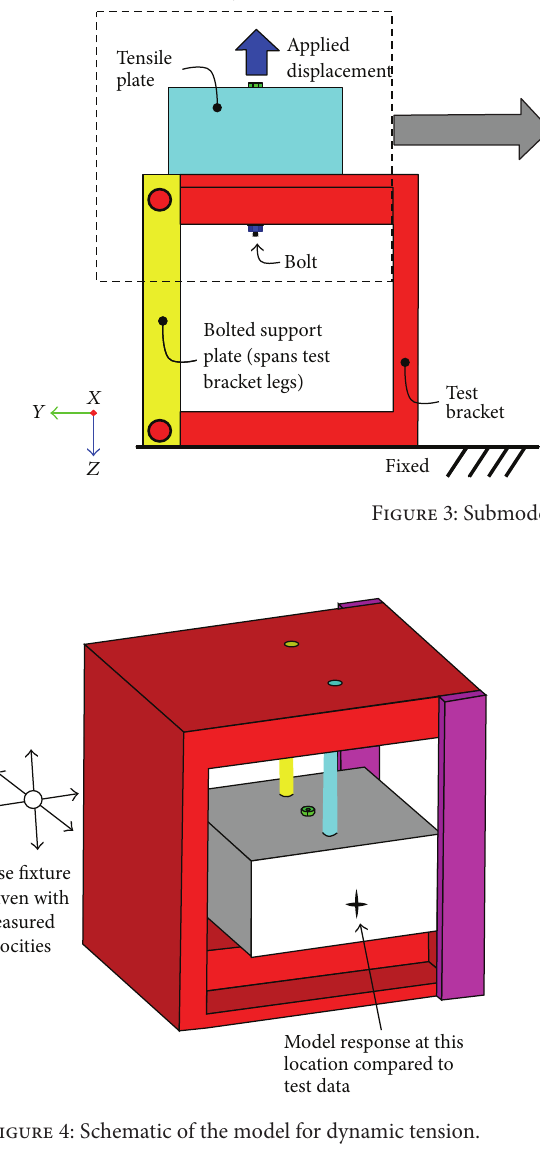
Figure 4: Schematic of the model for dynamic